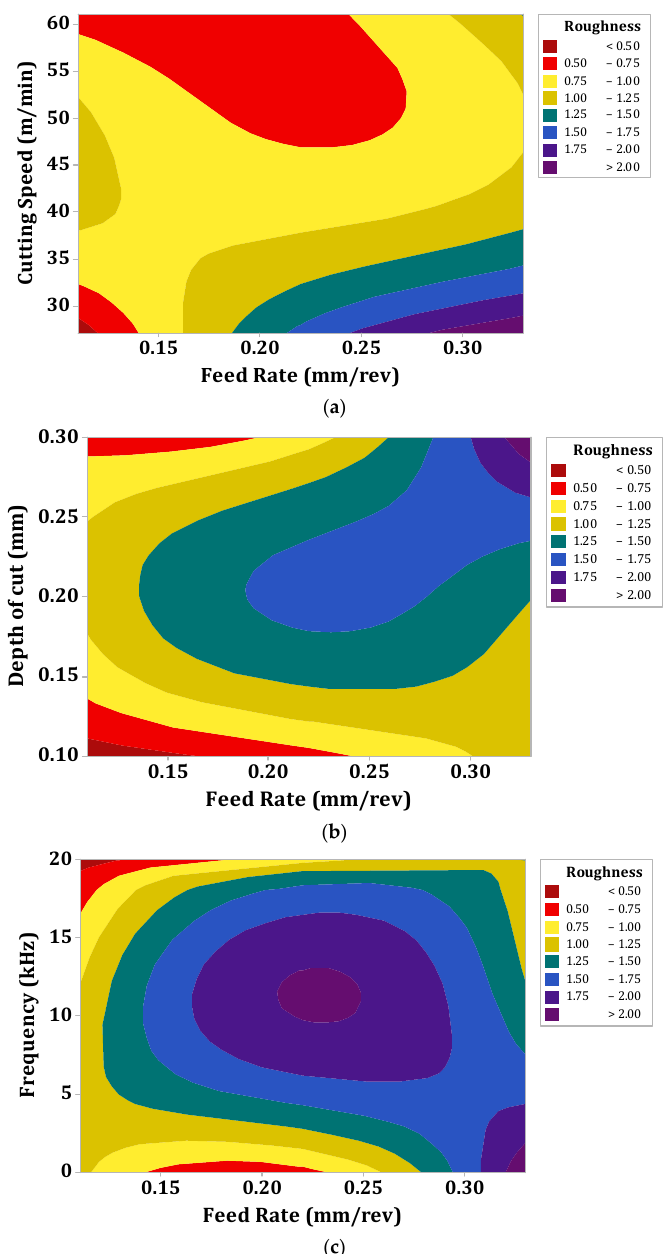
Figure 3. Influence of machining parameters on surface roughness values ( a ) Cutting speed vs. feed rate, ( b ) depth of cut vs. feed rate, and ( c ) frequency vs. feed rate. Lastly, Figure 3c depicts the contour effect plot of frequency vs. feed rate. This plot exhibits that the lower value of surface roughness was achieved at the higher frequency of cutting tool i.e., at 20 kHz frequency. Moreover, this plot shows that the conventional machining process produced a higher value of surface roughness and it decreased with the change in frequency of cutting tool i.e.,